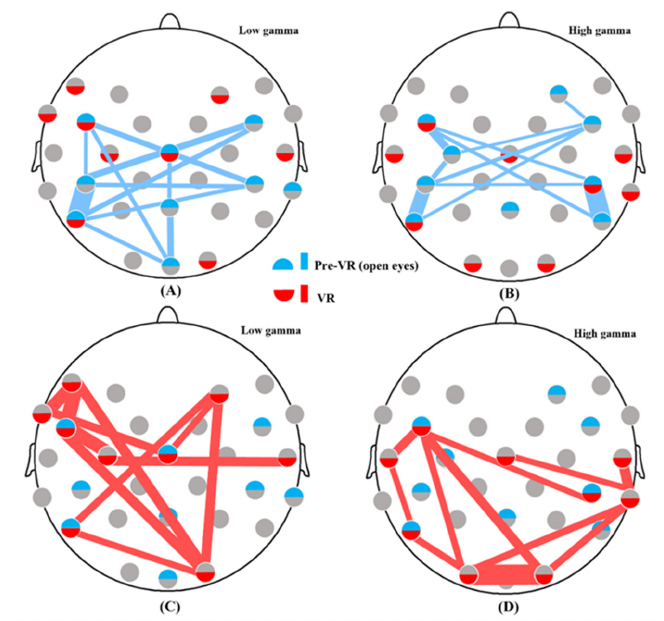
Figure 4. Variations of the top 30% connections among hubs in stages one and three at different frequency bands: ( A ) The top 30% of hub connections in stage one in the low gamma band; ( B ) The top 30% of hub connections in stage one in the high gamma band; ( C ) Top 30% of hub connections in stage three in the low gamma band; ( D ) The top 30% of hub connections in stage three in the high gamma band. The connection width is proportional to the MI value.